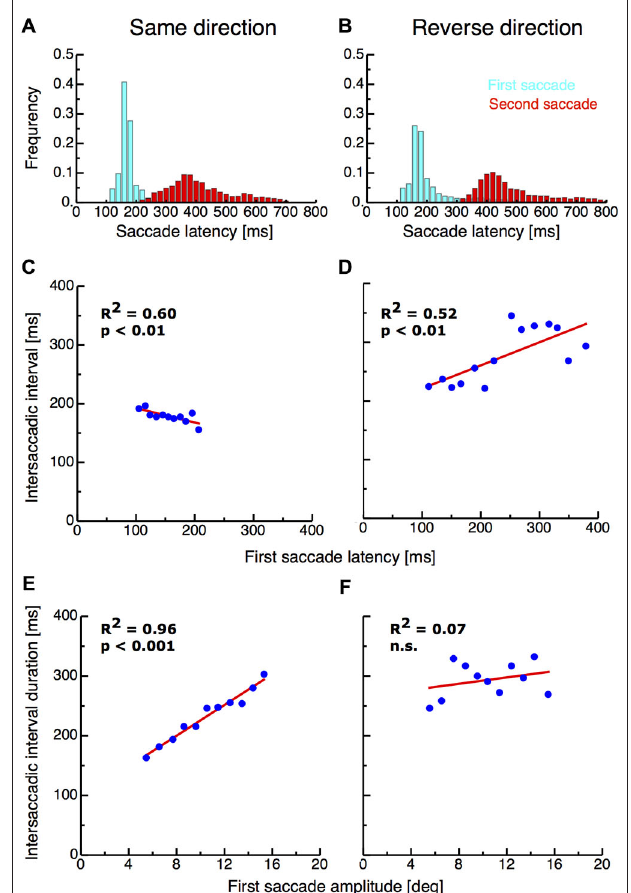
FIGURE 2 | (A,B) Saccade latencies for the first saccades and the intersaccadic interval in the same-direction and the reverse double-step task. Data are binned into bins with a width of 20 ms. (C,D) Intersaccadic interval duration as a function of first saccade latency in the